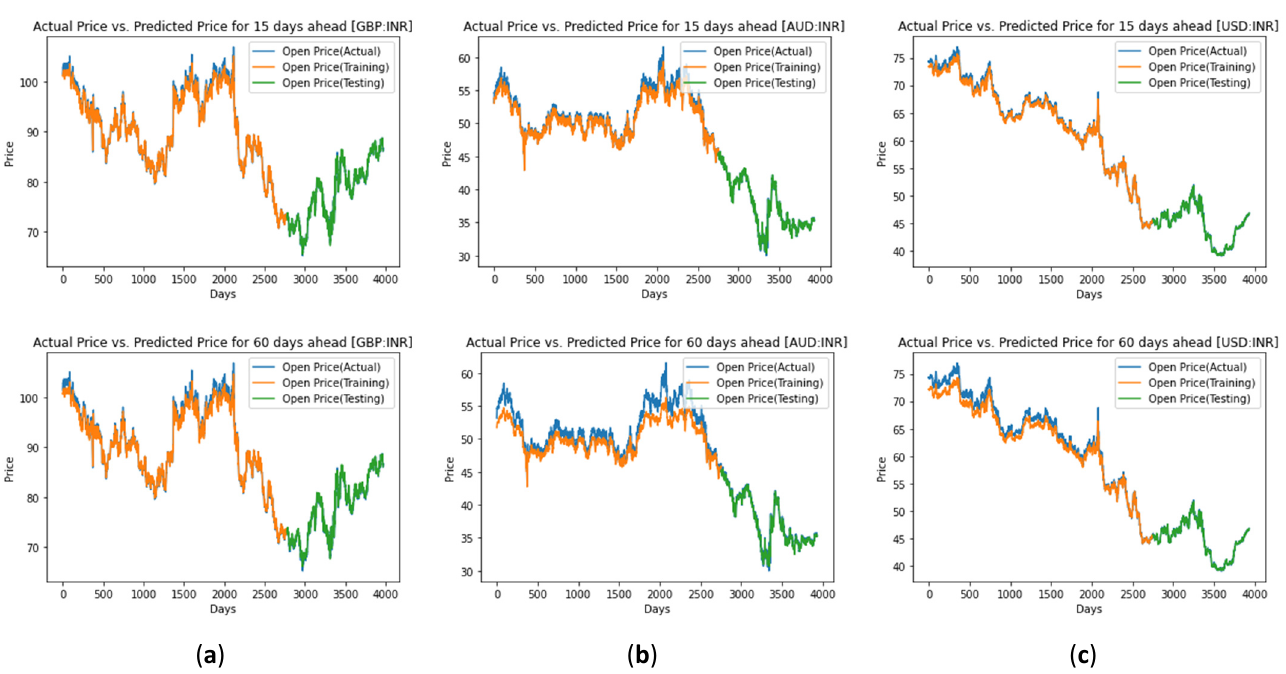
Figure 4. Short-term and long-term prediction graphs and MSE graphs using Stacked-LSTM for ( a )